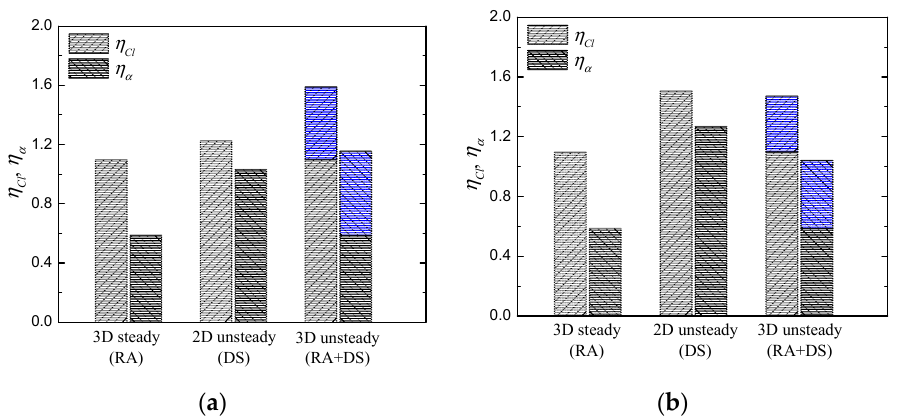
Figure 11. Stall-delay parameters of the 2D airfoil and 3D blade section. ‘RA’ denotes rotational augmentation, ‘DS’ dynamic stall, and ‘RA + DS’ combined effect of rotational augmentation and dynamic stall. Blue bars denote the unsteady effects on 3D blade flow. ( a ) V w = 13 m/s; ( b ) V w = 15 m/s.